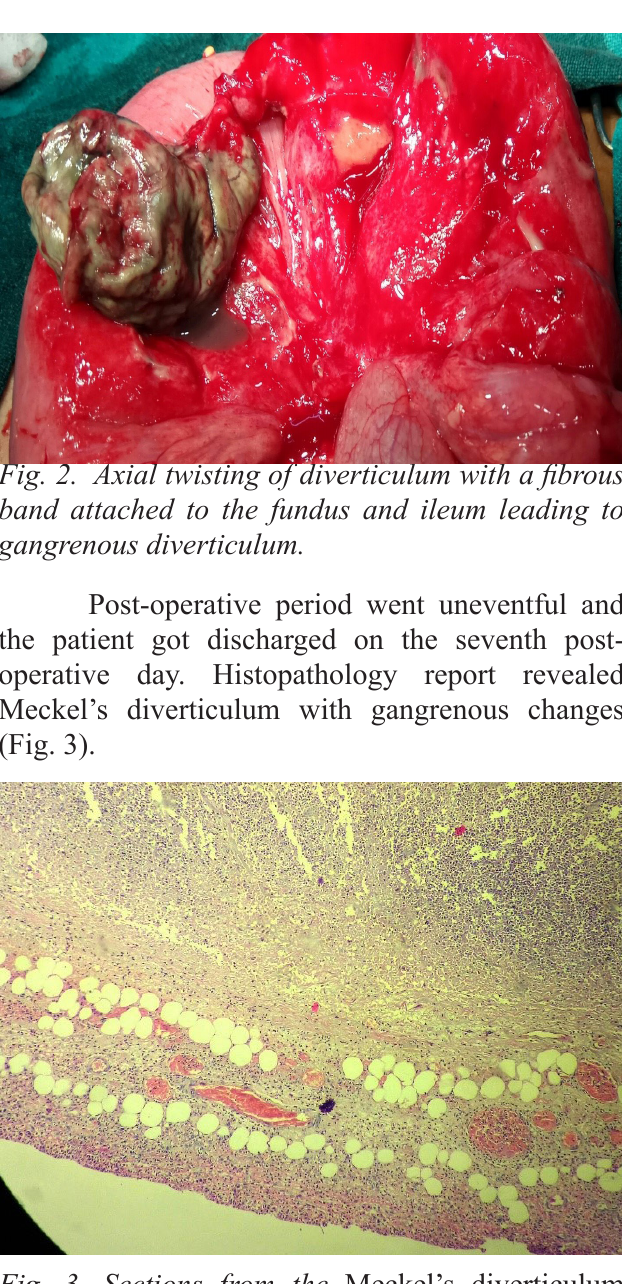
Fig. 1. Showing blind ended gas-filled structure at hypogastrium with thickened enhancing irregular wall associated with adjacent mesenteric fat plane stranding and prominent adjacent vessels suggesting inflammatory lesion.